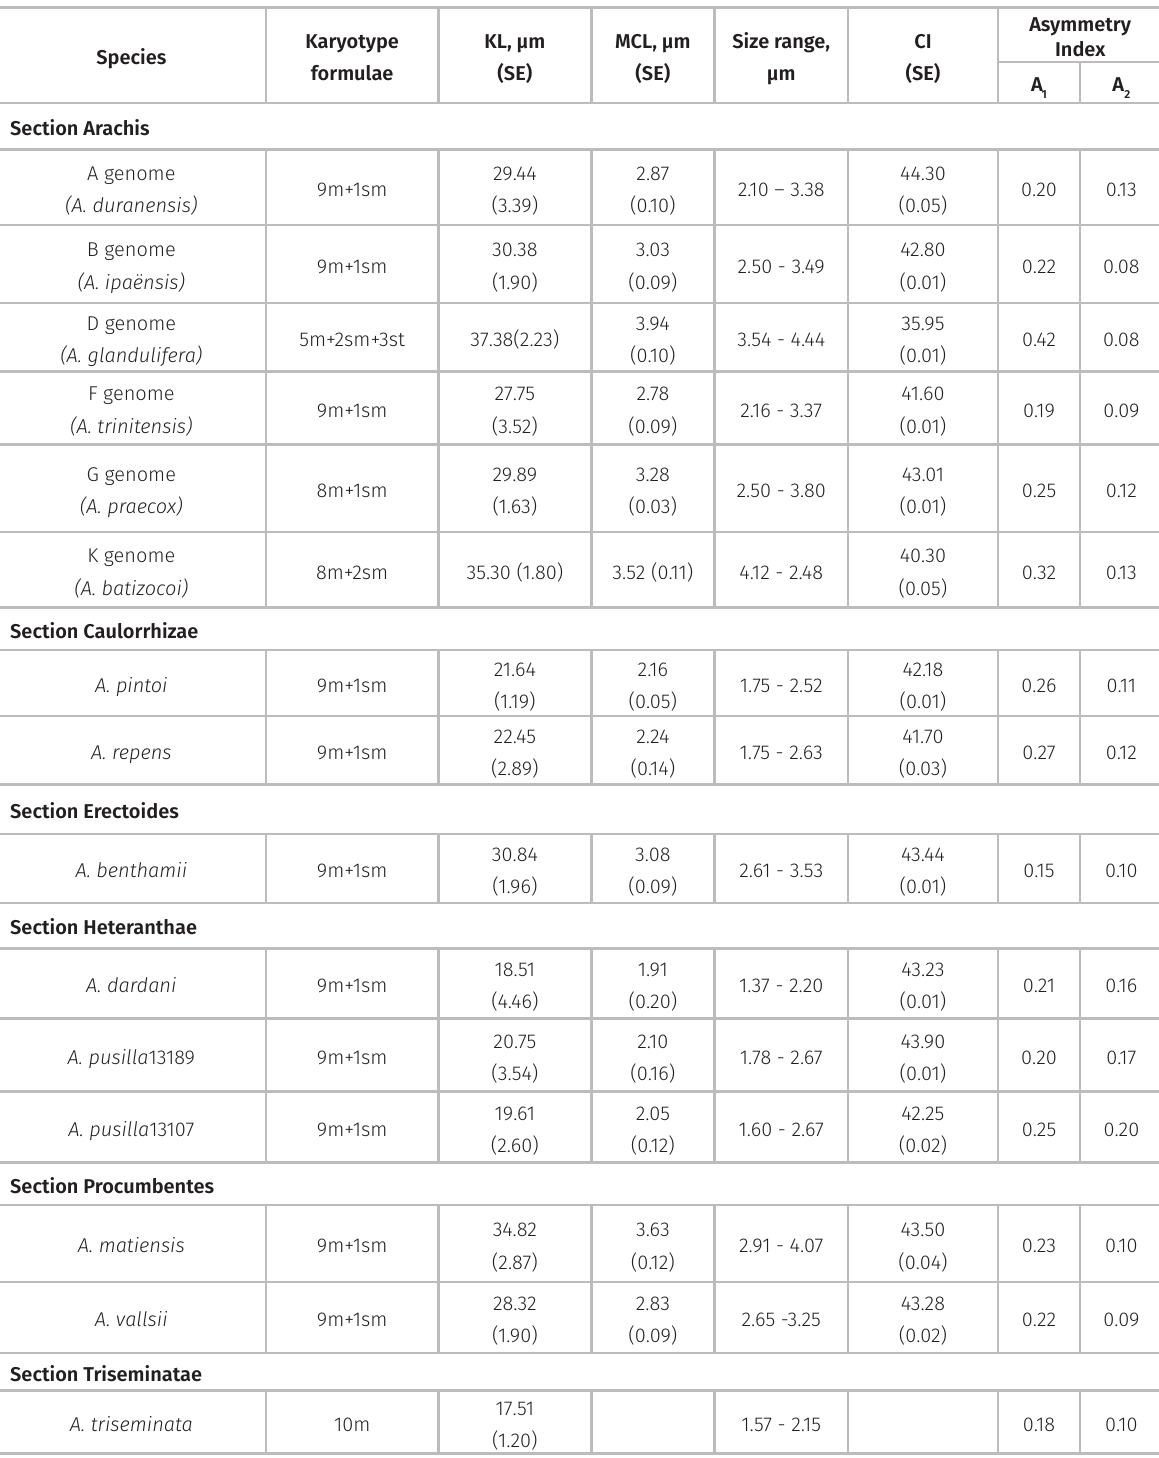
Table II. Karyotype features of species belonging to different sections of Arachis